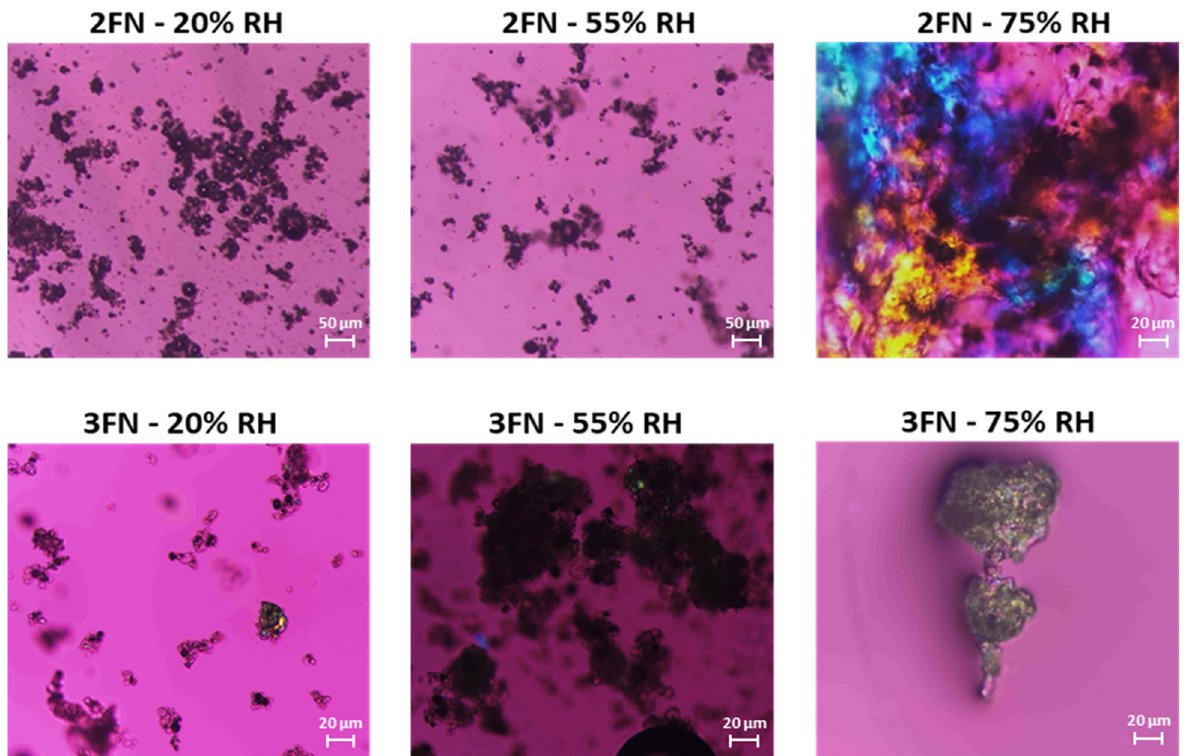
Figure 6. Polarized light microscopy images of naproxen-PVP dispersions (2FN and 3FN) stored under different humidity levels after 60 days.